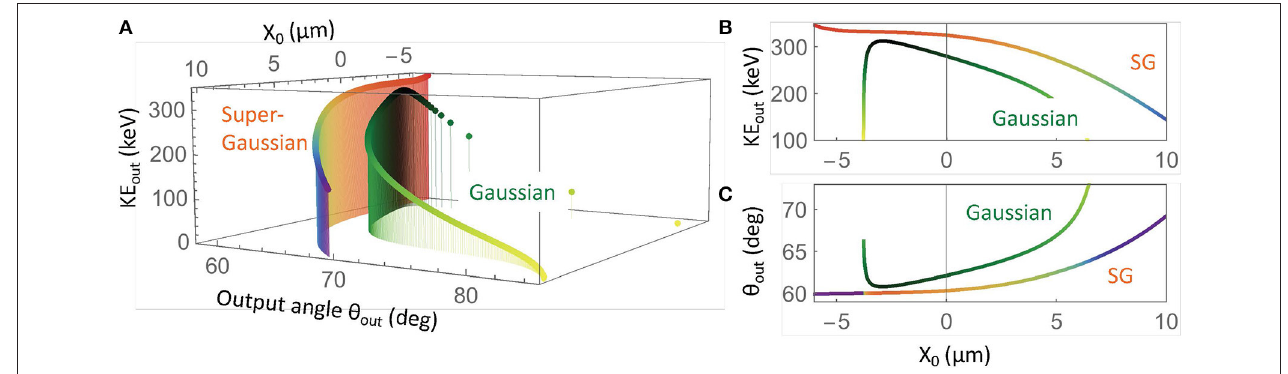
FIGURE 6 | Single particle calculations for electron acceleration from a finite beam with radius 15 µ m , a pulse duration of 20fs, a 60 ◦ PFT angle, and 100 keV peak ponderomotive potential. The two curves correspond to Gaussian and super-Gaussian transverse beam profiles. (A) output kinetic energy and angle as a function of the starting transverse position X 0 . The color shading corresponds to the output energy. (B) Projection onto the KE out − X 0 plane. (C) Projection onto the θ out − X 0